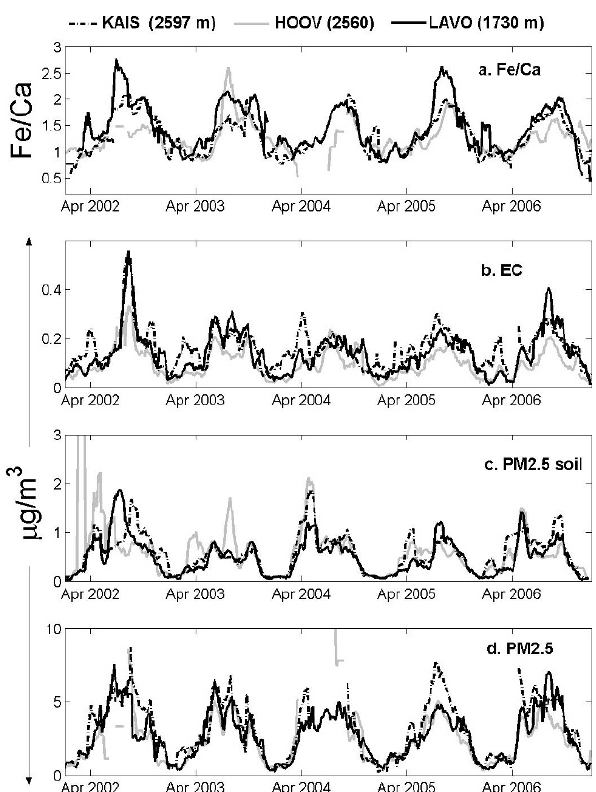
Fig. 5. Aerosol data from three IMPROVE (Interagency Monitoring for Protected Visual Environments) sites in Northern